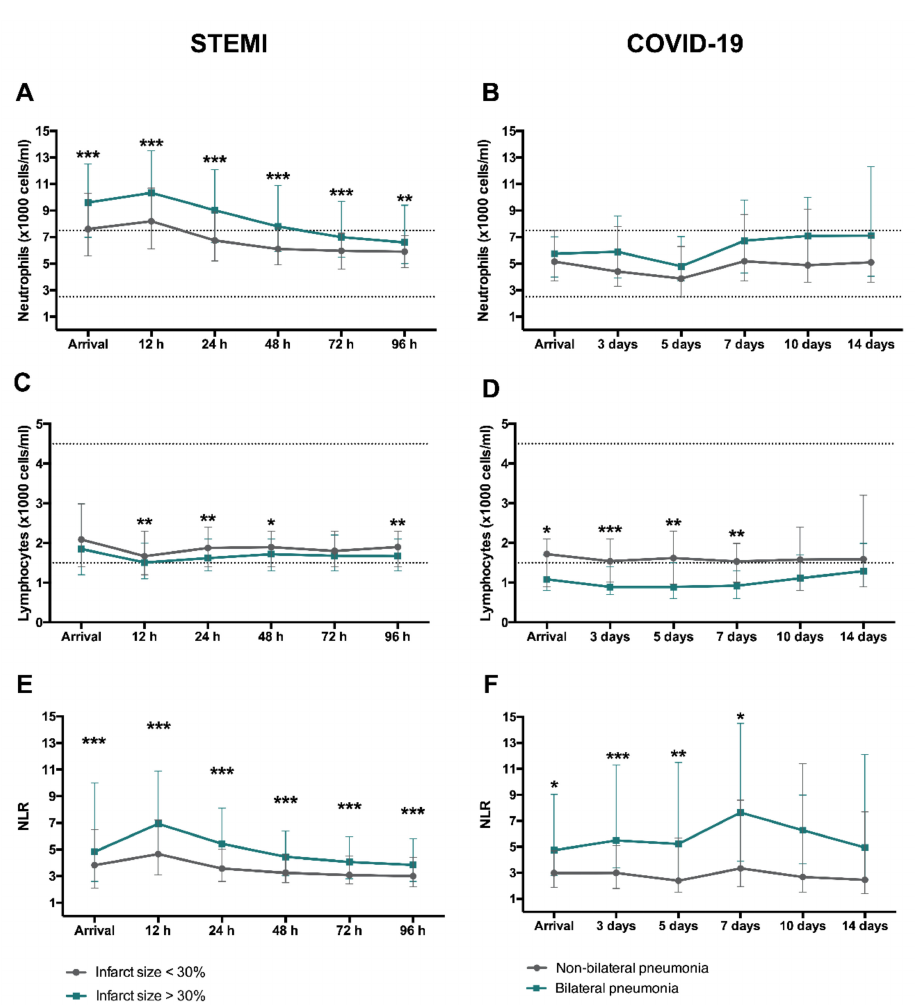
Figure 6. Dynamics of circulating neutrophil and lymphocyte counts and NLR according to structural damage after reperfused STEMI and COVID-19. In STEMI, patients were dichotomized according to the extension of CMR-derived infarct size (extensive: > 30% of LV mass and non-extensive: < 30% of LV mass). Time course of median neutrophil ( A ) and lymphocyte ( C ) ( × 1000 cells / mL) counts as well as NLR ( E ) depending on infarct size. In COVID-19, patients were dichotomized according to the extension of CT-derived bilateral pneumonia. Time course of median neutrophil ( B ) and lymphocyte ( D ) ( × 1000 cells / mL) counts as well as NLR ( F ) depending on the presence of bilateral pneumonia. Data were expressed as median [quartile 25-quartile 75]. Dotted lines represent the upper and lower ranges of normality. * p < 0.05, ** p < 0.01, *** p < 0.001. CMR: cardiac magnetic resonance; COVID-19: coronavirus disease 2019; CT: computed tomography; LV: left ventricular; NLR: neutrophil-to-lymphocyte ratio; STEMI: ST-segment elevation myocardial